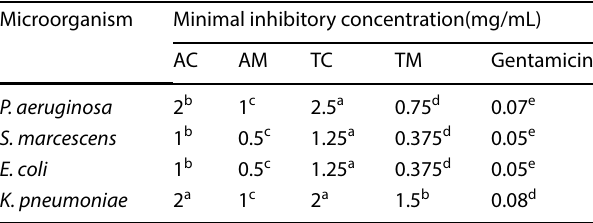
Table 4 Minimal Inhibitory Concentration (MIC) of the extracts against pathogenic bacteria